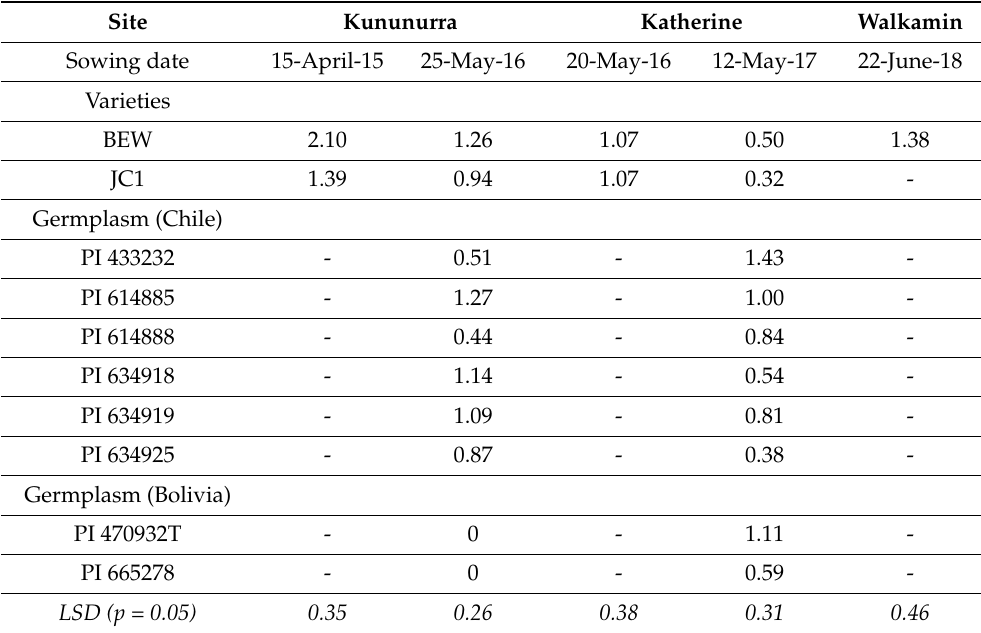
Table 8. Seed yield (t/ha) of quinoa varieties and germplasm at irrigated trial sites with a hot semi-arid climate (Kununurra) and a tropical savanna climate (Katherine, Walkamin). Site Kununurra